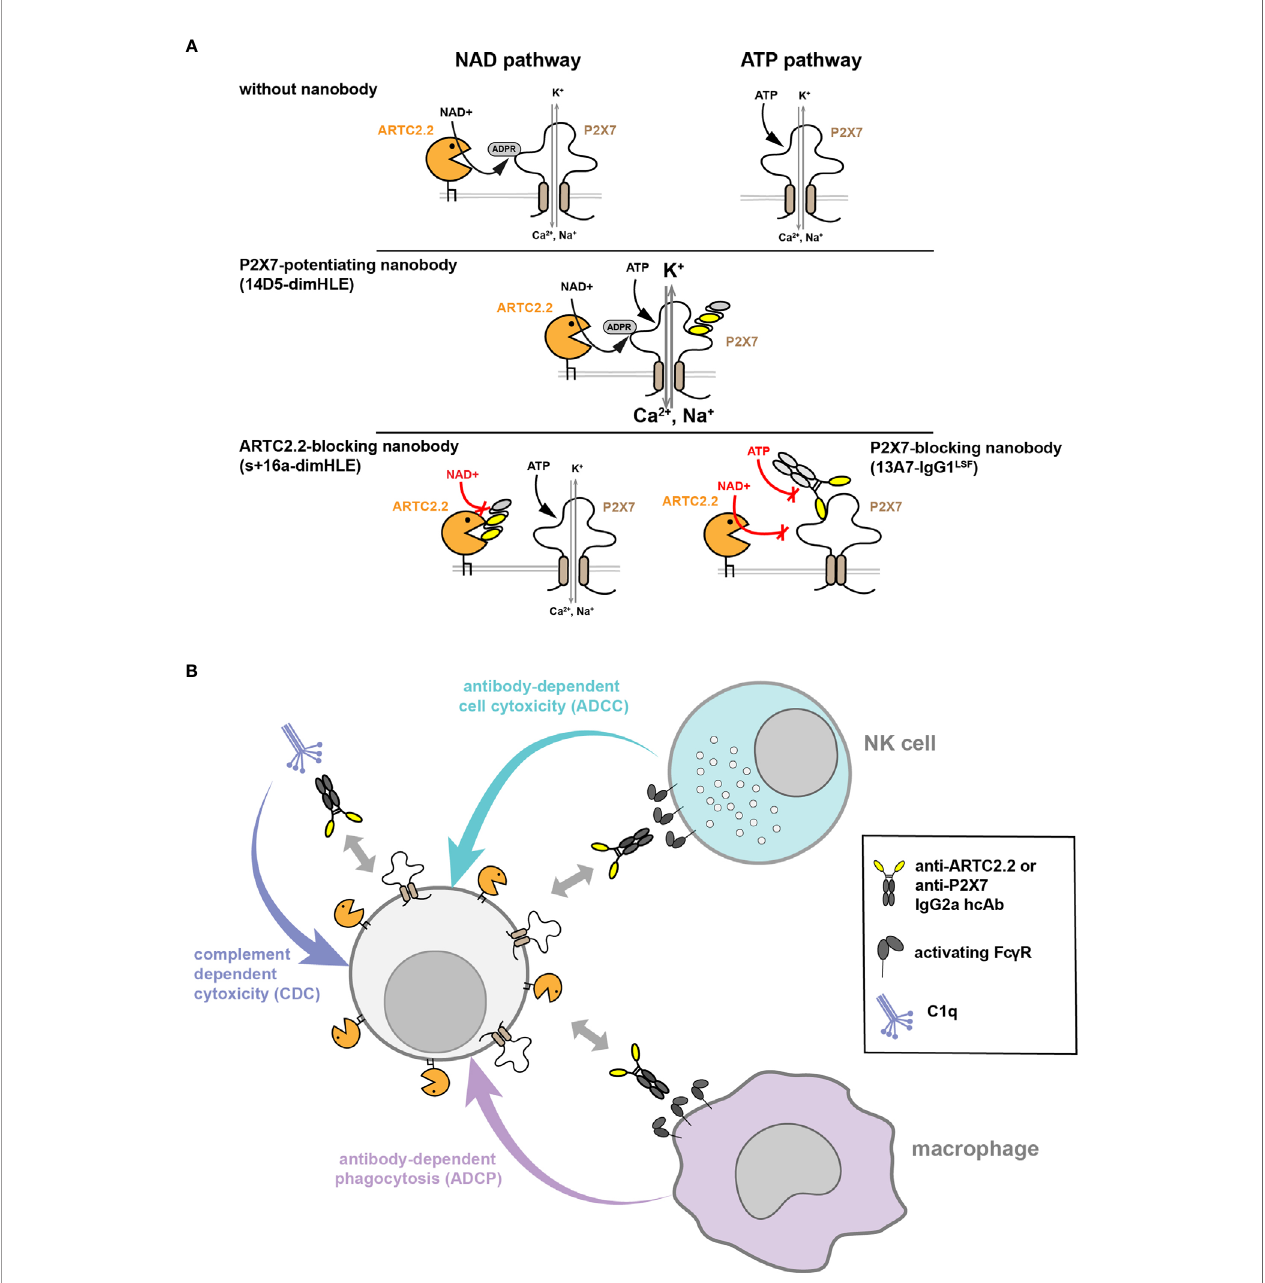
FIGURE 2 | Strategies used to manipulate ARTC2.2 or P2X7 functions in vivo or to deplete T cells expressing these proteins. (A) Modulation of ARTC2.2 and P2X7 activity using nanobody-based constructs. Two pathways can lead to the activation of P2X7 at the surface of mouse T cells. The ATP pathway involves direct gating of P2X7 ion channel by extracellular ATP. The NAD + pathway involves a post-translational modi fi cation of P2X7 catalyzed by the ectoenzyme ARTC2.2 resulting in its covalent ADP-ribosylation. The 14D5-dimHLE construct probably binds to an allosteric site on P2X7 and potentiates gating of the ion channel triggered by either ATP or NAD + . The s+16a-dimHLE construct was designed to block ARTC2.2 enzymatic activity in vivo and thereby to inhibit activation of P2X7 by the NAD + pathway (but not the ATP pathway). The 13A7-IgG1 LSF hcAb construct inhibits P2X7 gating and can be used to inhibit both ATP and NAD + pathways. (B) Other